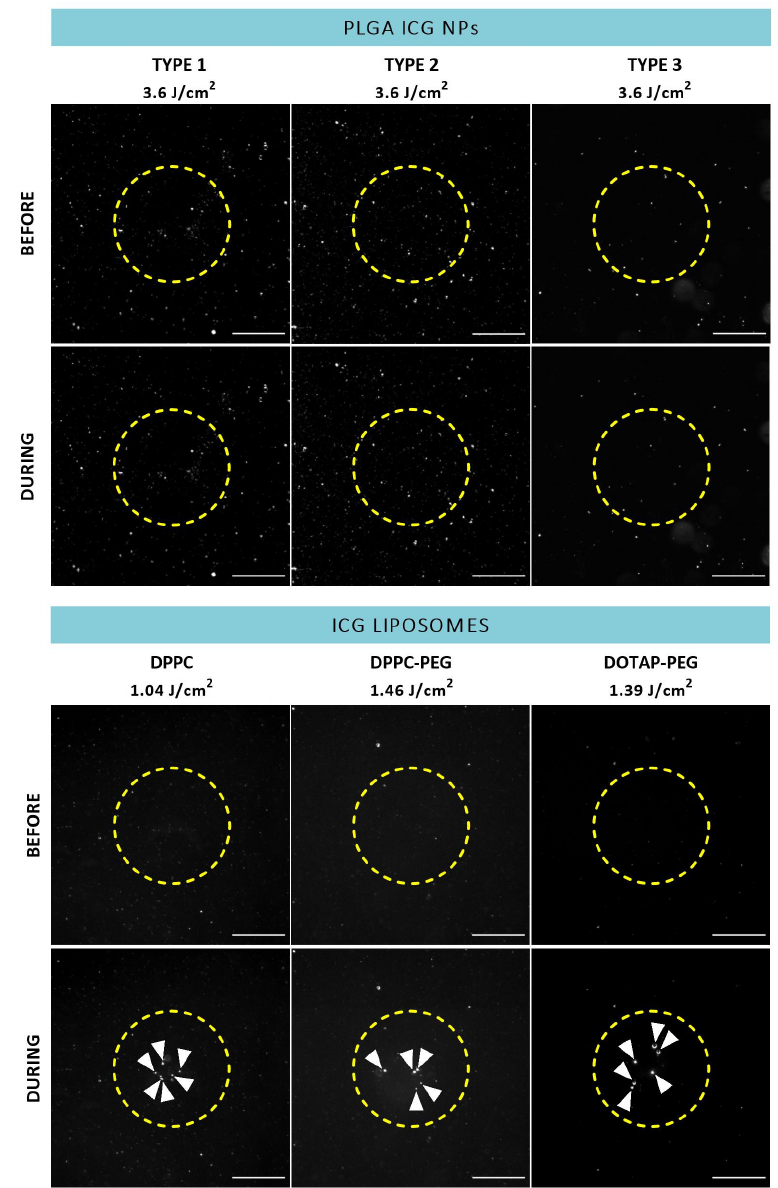
Figure 3. Dark field microscopy images of ICG NPs in buffer before and during application of a 7 ns laser pulse (ICG liposomes: 647 nm, ∼ 1.3 J/cm 2 , PLGA ICG NPs: 561 nm, ∼ 3.6 J/cm 2 ). White arrowheads indicate the presence of VNBs. Yellow dotted line represents the size of the laser beam. Scale bar = 75 µm.